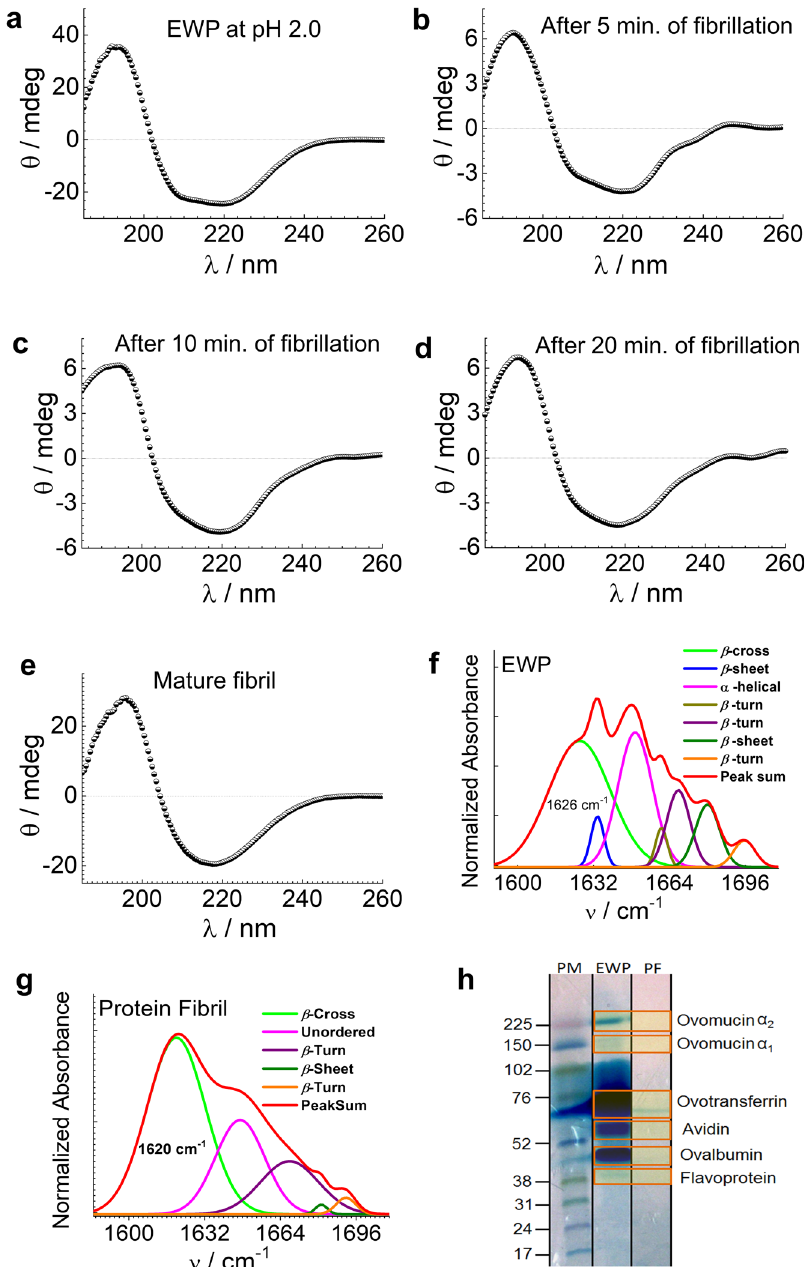
Fig. 4 Proteins secondary structural changes and proteins involved in fi brillation. a Circular dichroism (CD) spectrum of EWP showing all- α conformation . b – e CD spectrum showing transition in all- α conformation of EWP upon fi brillation at different time interval to antiparallel- β or cross- β in fi brils . f , g Deconvoluted FT-IR spectra showing changes in secondary structure of EWP f before fi brillation and g after fi brillation. h SDS-PAGE results of the protein markers (PM), egg white proteome (EWP) solution, and protein fi brils (PF)